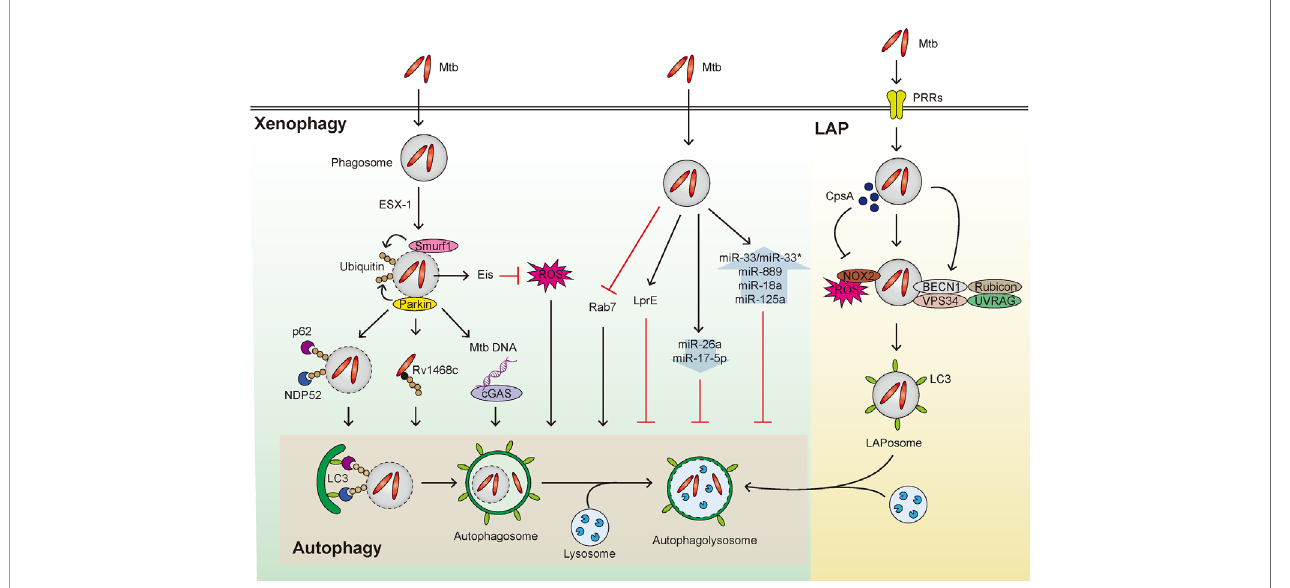
FIGURE 1 | Overview of xenophagy and LAP during Mtb infection. Xenophagy and LAP are activated in host cells during Mtb infection. (Left) Mtb that enters the host cells by phagocytosis can reside within phagosomes and resist fusion with lysosomes. The phagosome is then damaged by the ESX-1 system to induce Smurf1- and Parkin-mediated ubiquitination, thereby adaptor proteins such as p62 and NDP52 are recruited leading to formation of autophagosome. Also, Rv1468c, a surface protein of Mtb that escapes from the phagosome, induces xenophagy by binding with ubiquitin. In addition, the Mtb DNA exposed to the cytosol from the damaged phagosome is recognized by cGAS to induce xenophagy. Both the enhanced intracellular survival (Eis) gene of Mtb and putative Mtb lipoprotein LprE inhibit autophagy. Additionally, several miRNAs that inhibit xenophagy are shown in the context of mycobacterial infection. In addition, Mtb inhibits the recruitment of Rab7, thus disturbing the fusion of autophagosome and lysosome. (Right) Various PRRs recognize Mtb and invade the host cell. Rubicon complex (Rubicon- BECN1-VPS34-UVRAG) and NOX2-dependent ROS are important in the activation of LAP. In this process, LAPosome, a single membrane surrounded by LC3 is formed, which fuses with lysosome to eliminate Mtb. At this time, it is known that CpsA, a protein of Mtb, interferes with the LAP